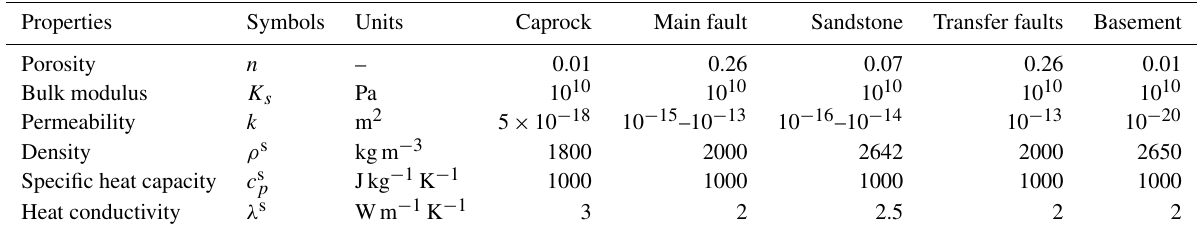
Table 2. Fluid properties (Smith and Chapman, 1983; Linstrom and Mallard, 2001; Watanabe et al., 2017). Properties Symbols Units Coefficient of thermal expansion